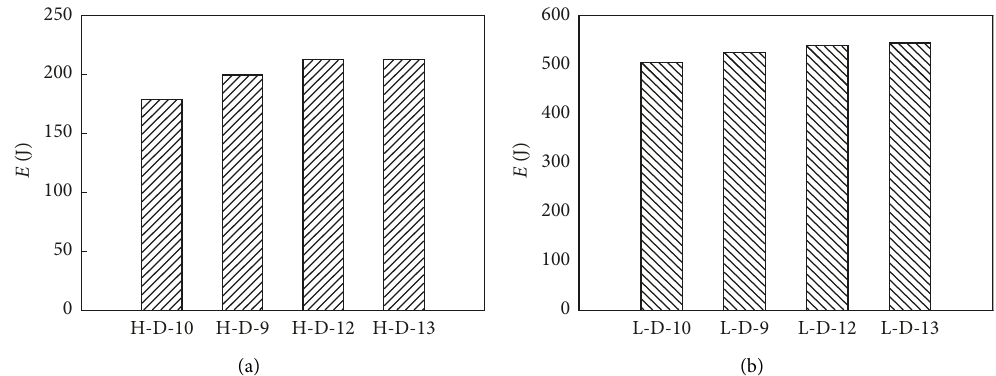
Figure 10: Hysteresis energy of material specimens under different thickness and loading modes. (a) Hysteresis energy of specimens with label H-D. (b) Hysteresis energy of specimens with label